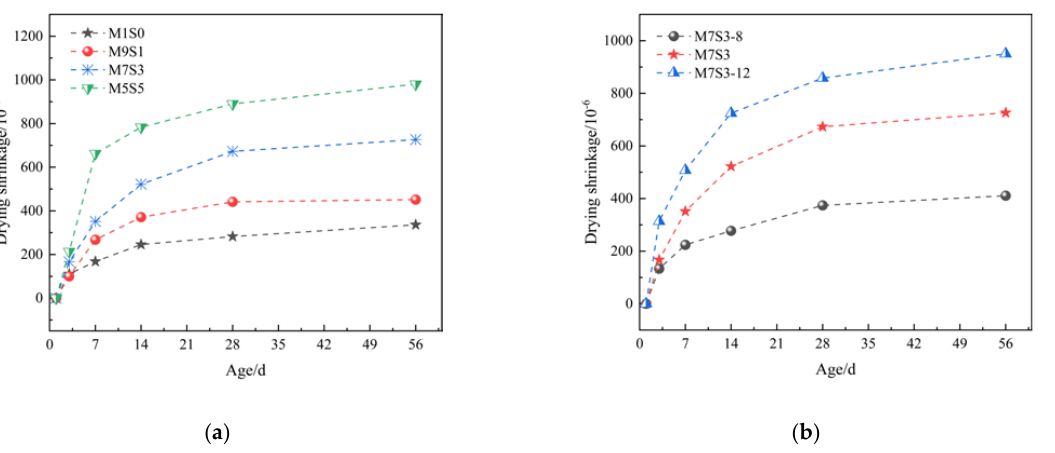
Figure 5. Drying shrinkage of AAMS composite cementitious materials. ( a ) Different slag contents. ( b ) Different Na 2 O